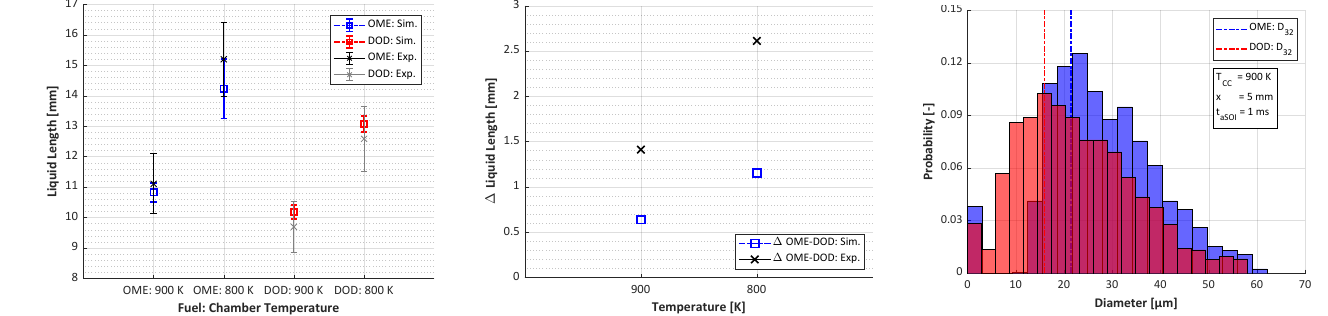
Figure 5. Conti3L: ( left ) Steady state liquid length (plv penetration). ( center ) Difference in liquid length between fuels. ( right ) Droplet diameter distribution. Table 9. Conti3L: Inert liquid length results for OME and dodecane.